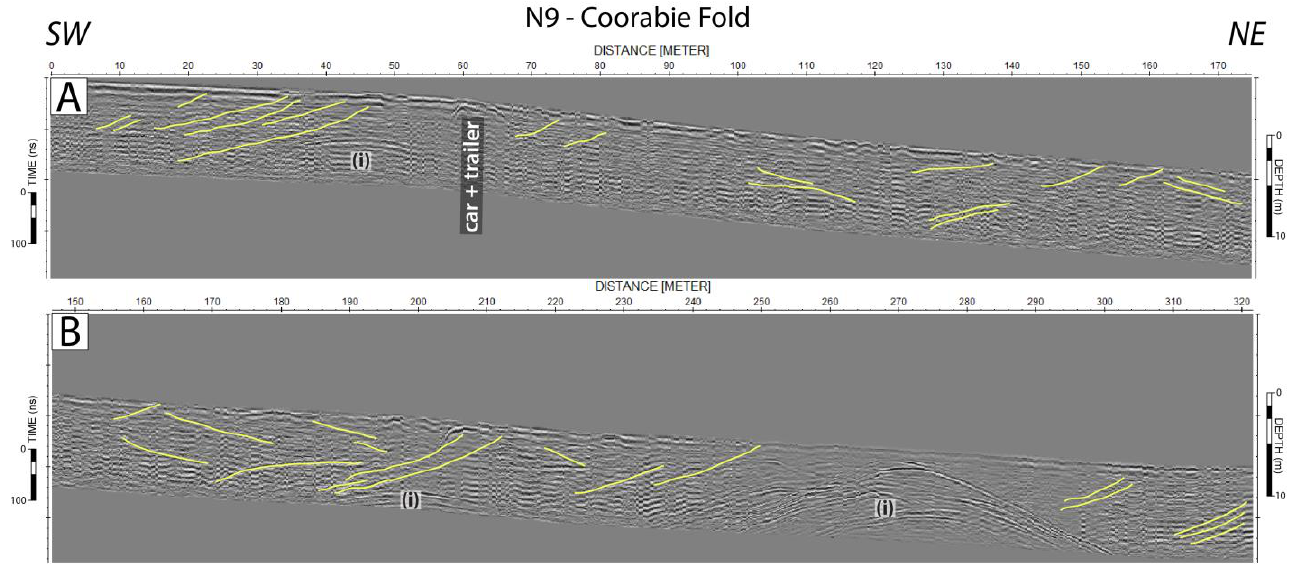
Figure 12. ( A , B ): GPR transect N9, interpreted reflectors shown in yellow; (i): wide hyperbolas indicating airwave reflections from trees.